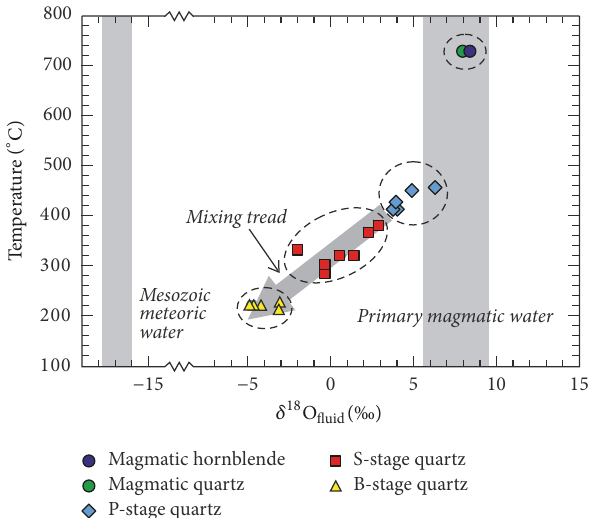
Figure 8: Homogenization temperature versus calculated oxygen isotopic value plot of magmatic hornblende and quartz, and hydrothermal quartz from three different paragenetic stages in Haisugou. The compositions of primary magmatic water [35] and the Mesozoic meteoric water in the northern Xilamulun district, northeastern China [36], are also shown for comparison. P-, S-, and B-stage refer to pre-, syn-, and postmineralization stage,